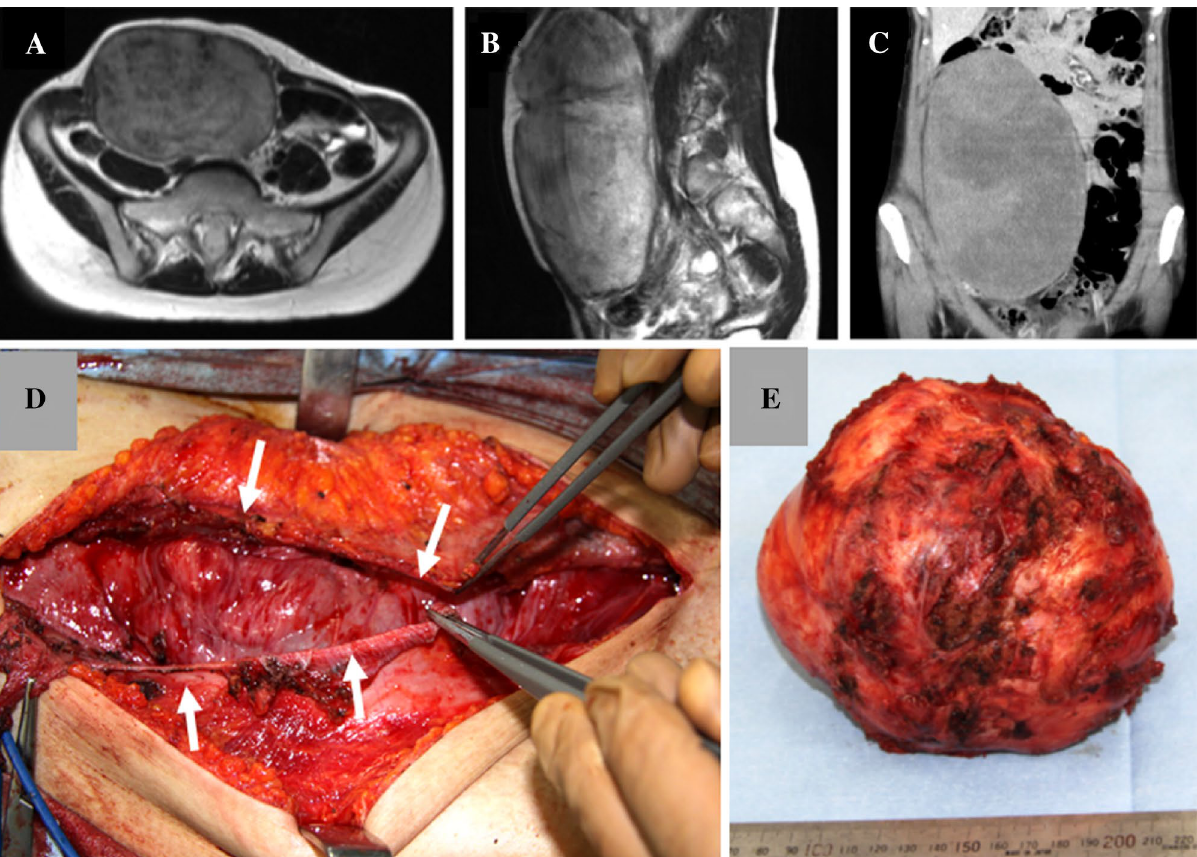
Figure 2. Preoperative images, and findings during fascia-sparing surgery. Patient 1 ( A – D ). Preoperative MRI and CT. T2-weighted axial plane ( A ), T2-weighted sagittal plane ( B ), Contrast-enhanced sagittal plane of CT ( C ). Fascia (white arrows) was preserved after removal of tumor ( D ). Patient 4. Removed desmoid detached from fascia ( E ). (Adobe photoshop CS6 ver.13.0 × 32, Microsoft PowerPoiont